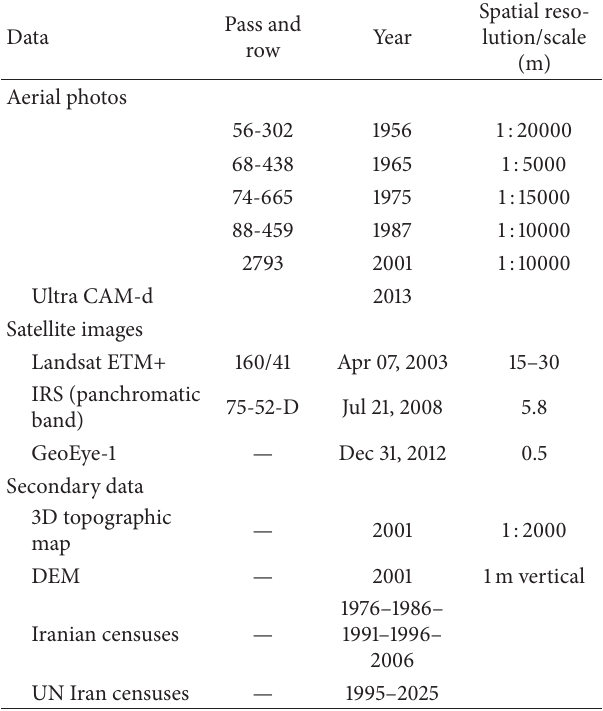
Table 1: Data used in this study.